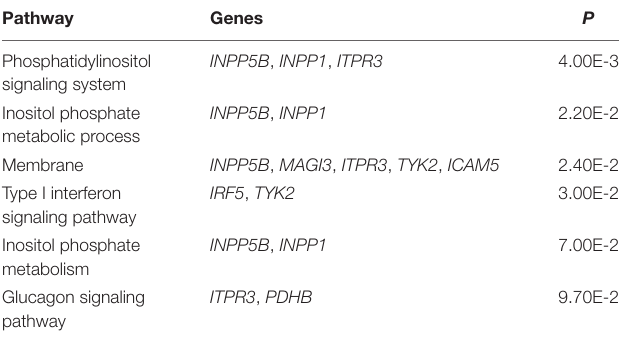
TABLE 1 | Potential pleiotropic genes associated with RA and SLE identified by ccFDR.